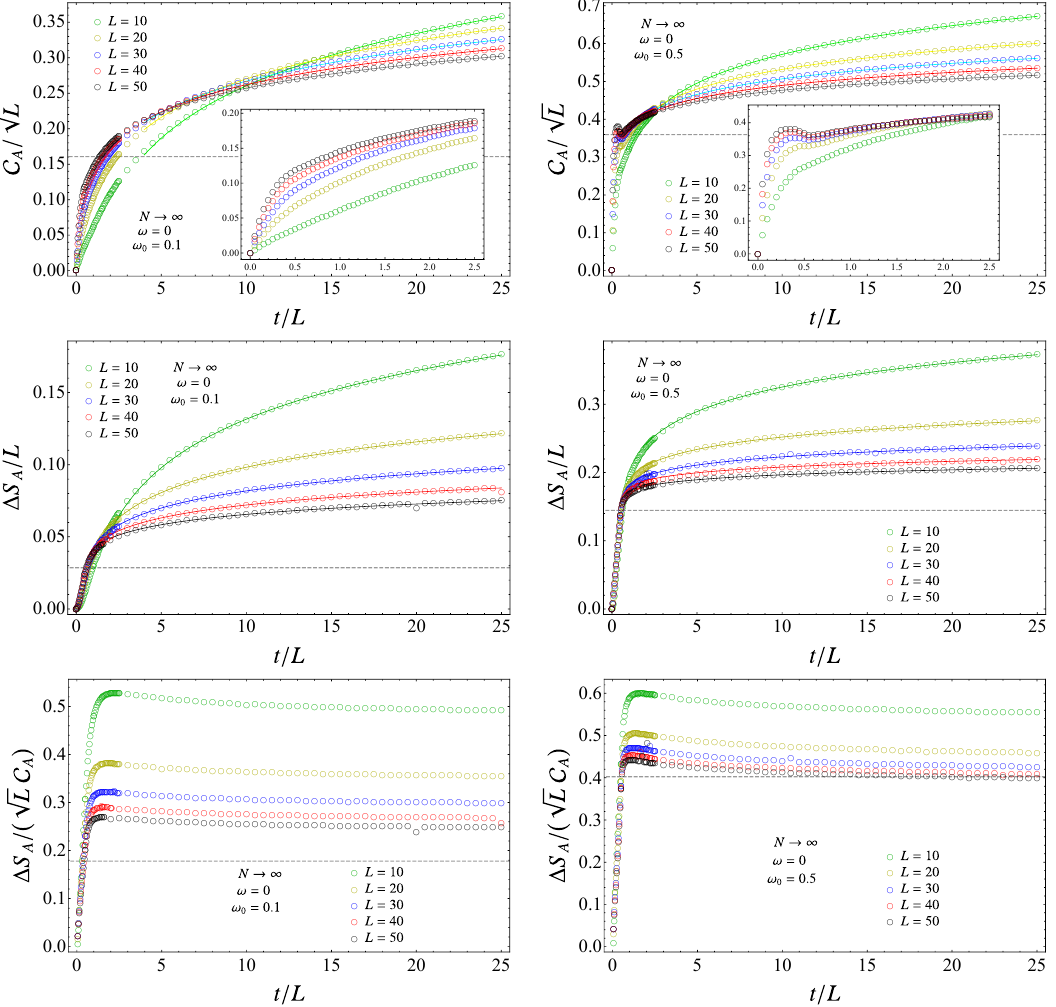
Figure 23 . Temporal evolutions after a global quantum quench with a gapless evolution Hamilto- nian and either ω 0 = 0 . 1 (left panels) or ω 0 = 0 . 5 (right panels) of C A (top panels), of ∆ S A (middle panels) and of ∆ S A / C A (bottom panels) for a block made by L consecutive sites in an infinite harmonic